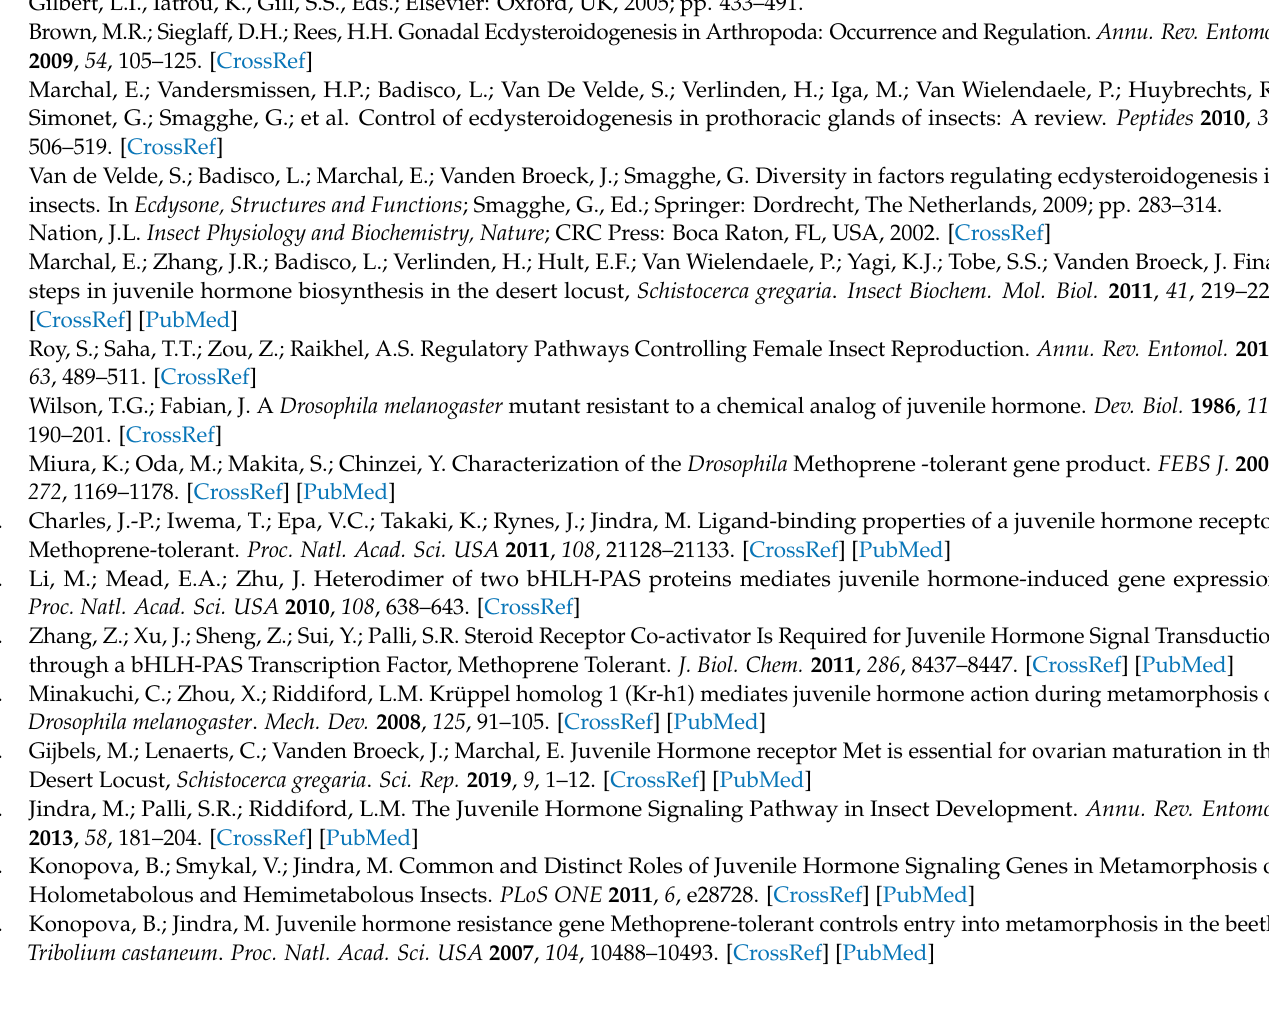
dsRNA construct design, Table S2: Oligonucleotide sequences of primers used in q-RT-PCR, Table S3: List of species and accession numbers of protein sequences used in the phylogenetic